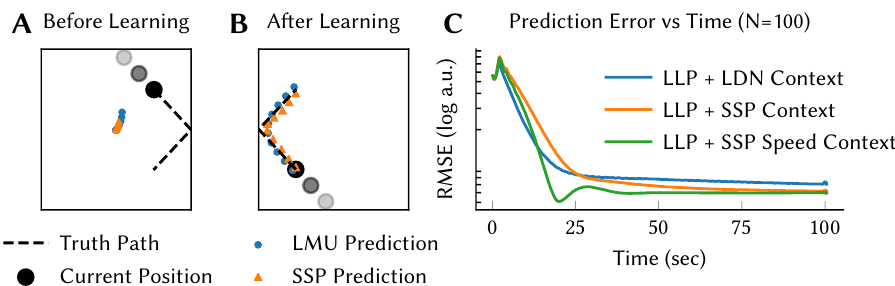
Figure 7. One trial of LLP learning to predict the motion of a ball bouncing off the walls of a box with lossless collisions. ( A ) Initially the system cannot predict the future motion of the ball. ( B ) Using a LDN dimensionality of q = 10, the LLP learns to predict the future motion of the ball. ( C ) shows the windowed mean (window of 1 s) of the root mean square error of the predicted path for the LLP algorithm with three different context representations over 100 trials. The LDN context uses an LDN to summarize the recent motion of the ball. The SSP context encodes the current position of the ball, and the SSP Speed context encodes the position and velocity of the ball. For each context encoding we used the largest learning rate that provided a stable learning rule. The solid line is the average performance, and the shaded regions (not visible in plot) represent a 95% confidence interval. While the SSP algorithms learn more slowly than the LLP with the LDN context, they ultimately reach lower prediction error. In all cases, by working in the LDN’s compressed representation we can learn to predict delayed signals, updating historical predictions with simple linear